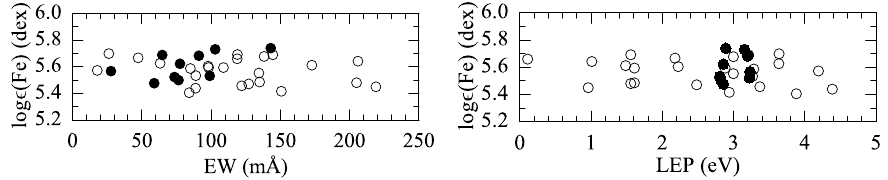
Fig. 3. Plot of the derived abundances from Fe I ( ◦ ) and Fe II ( • ) lines vs. the equivalent widths and the lower excitation potentials of these lines calculated for ξ t = 1.9 km s − 1 and T eff = 4400 K.